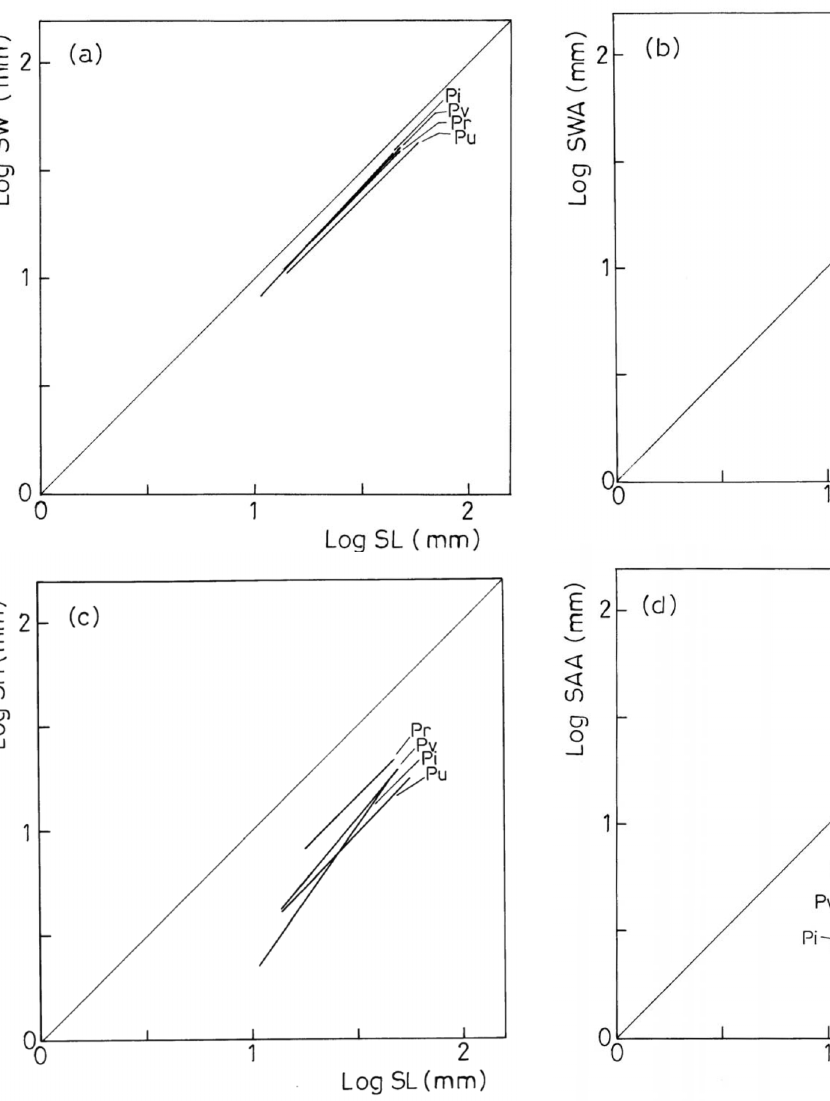
Fig. 4. Plots of the logarithm of shell measures against the logarithm of shell length. (A) Shell width (SW). (B) Shell width at the apex (SWA). (C) Shell height (SH). (D) Shell length from apex to anterior end (SAA) (Pi = P. intermedia , Pr = P. rustica , Pu = P. ulyssiponensis , Pv = P. vulgata